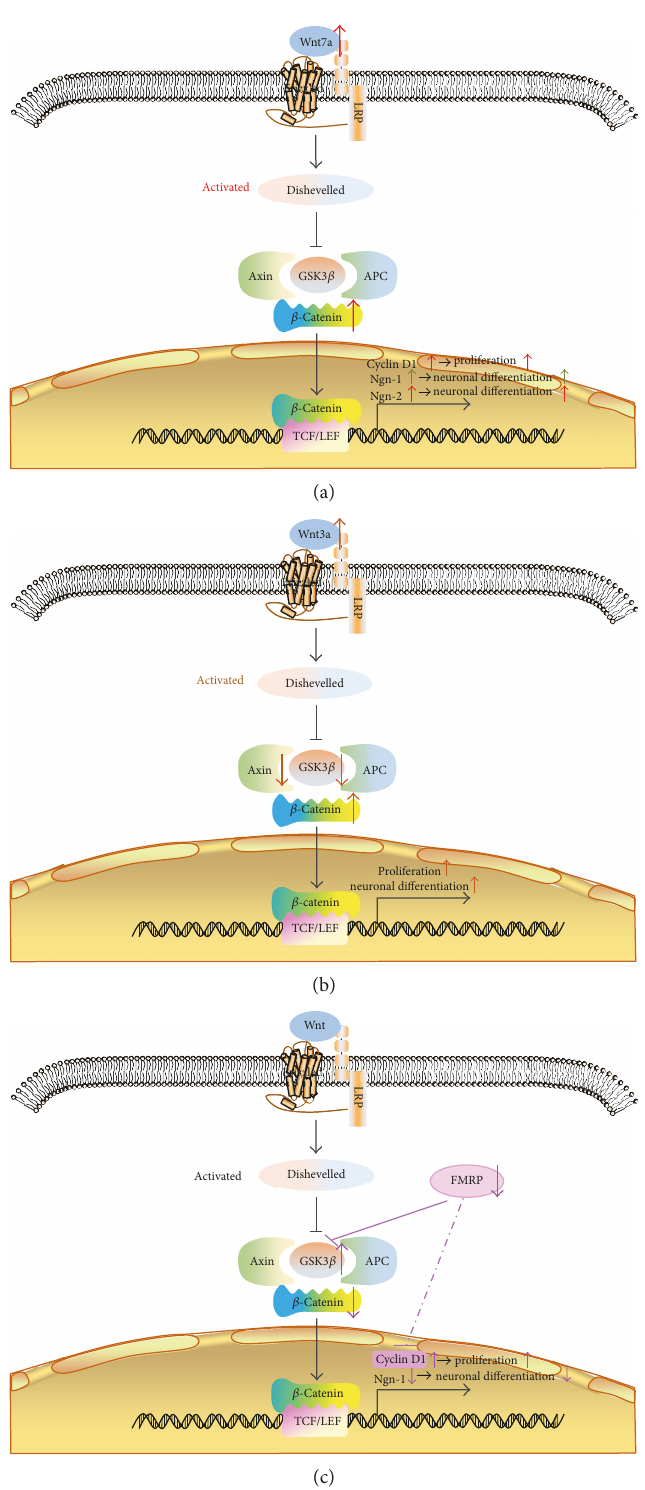
Figure 1: E ff ects of di ff erent proteins on the Wnt signaling pathway. (a) The increase in the expression of Wnt7a activated the Wnt7a/ β - catenin-cyclinD1 pathway, which stimulated the proliferation of NSCs, and induced the Wnt7a/ β -catenin-Ngn2 pathway, which promoted the neuronal di ff erentiation (the red arrows). In the cerebral cortex of mice, the overexpression of Wnt7a could increase the level of Ngn-1 mRNA and then induce the di ff erentiation of NSCs into neurons (the green arrows). (b) The overexpression of Wnt3a activated the Wnt signaling pathway and promoted the proliferation and neuronal di ff erentiation of NSCs. (c) The loss of FMRP resulted in a decrease in the level of β -catenin, then downregulated the expression of Ngn-1 and reduced neuronal di ff